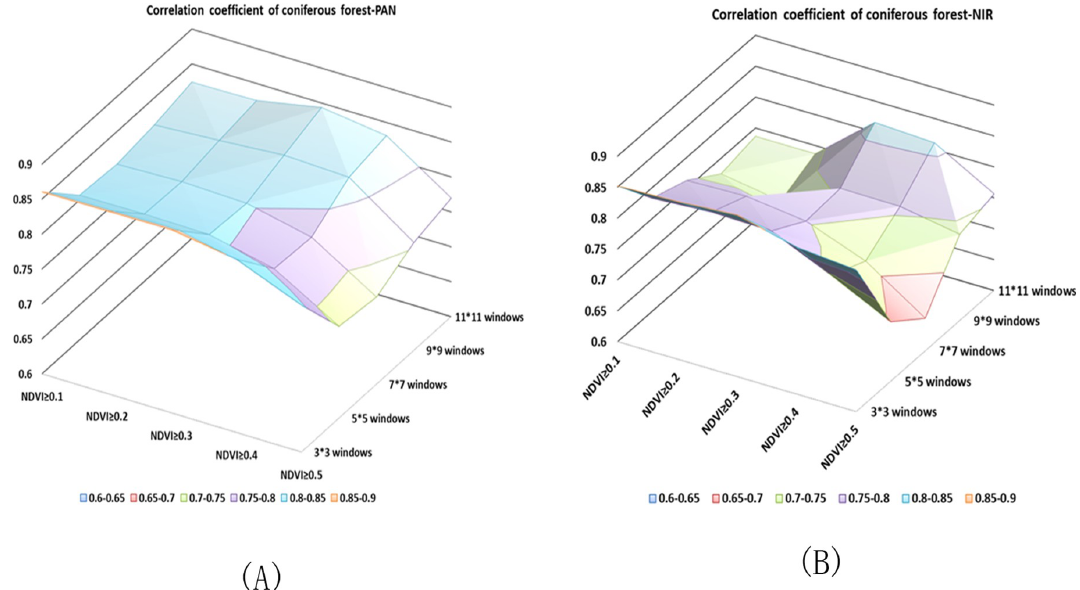
Fig 4. Correlation Coefficients of coniferous stand between stand density based on different window sizes and NDVI threshold and true stand density. (A) Correlation coefficient of the PAN. (B) Correlation coefficient of the NIR.